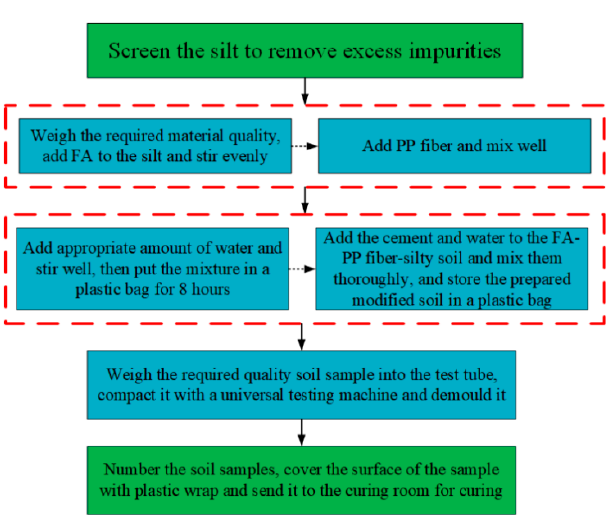
Figure 2. Test soil sample preparation process.